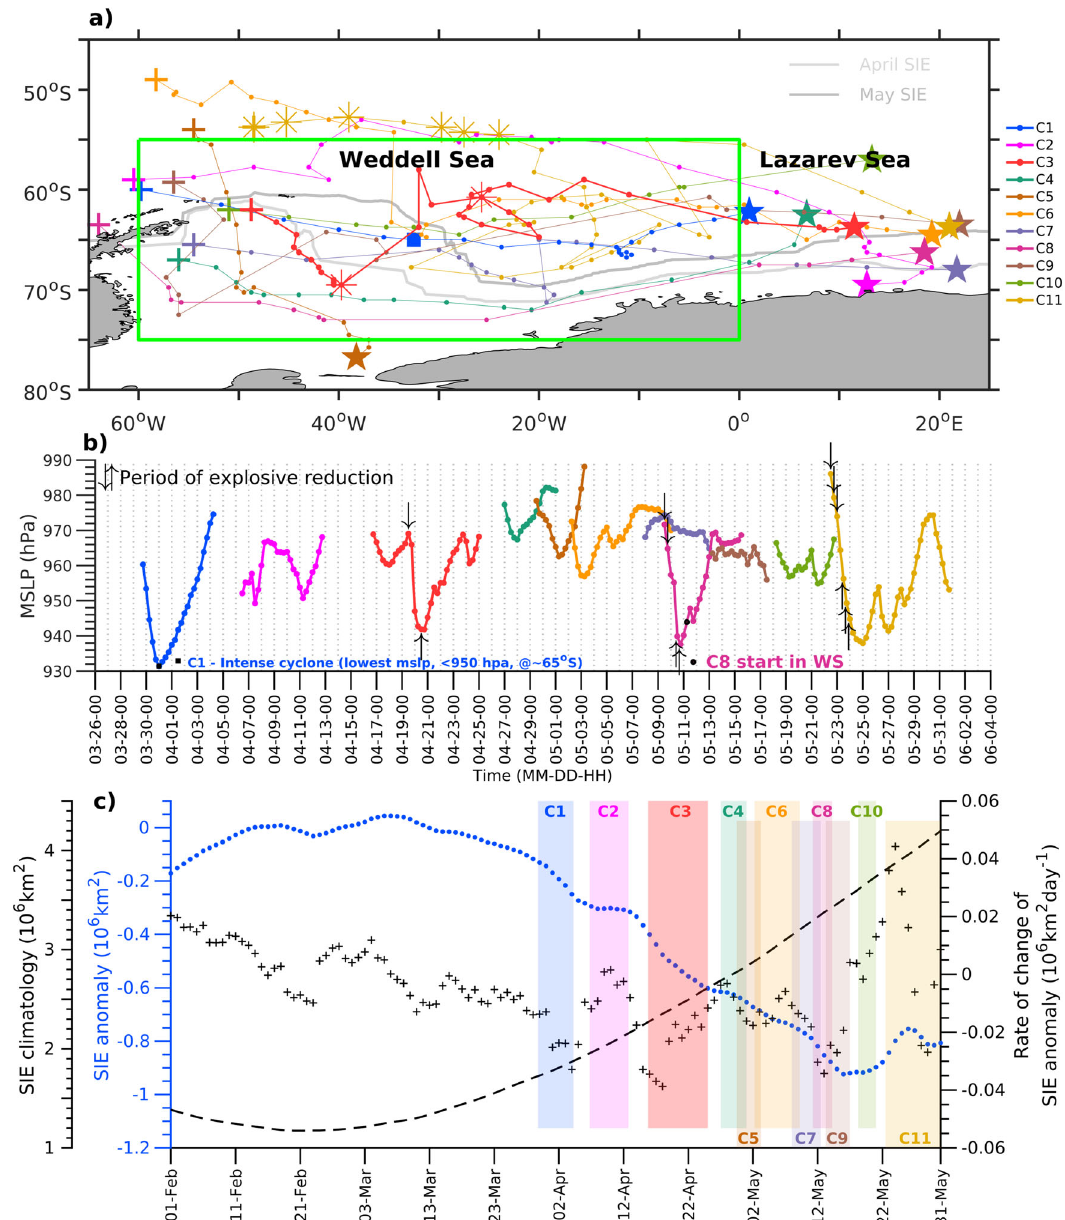
Fig. 2 Polar cyclones and sea ice extent (SIE) changes in the Weddell Sea. a Polar cyclone tracks during April – May 2019 are marked by lines with the dots indicating positions at 6 hourly intervals. Of the eleven cyclones (C1 – C11), three systems were explosive in nature (C3, C8, C11) that formed south of 60°S in the Weddell Sea during 16 – 25 April 2019 (C3), 11 – 15 May (C8), and 22 – 31 May 2019 (C11). Blue square represents the location of an unusual intense cyclonic system (C1) with a record low pressure. Occurrences of explosive events are marked in asterisks. For most of the systems, the cyclolysis (stars) occurred in the Lazarev Sea. The monthly sea ice edge relative to the cyclone tracks are shown for April (light gray) and May (dark gray) 2019. b Life cycle of polar cyclones including intense (square) and explosive (arrows) developments (Methods section ‘ Atmospheric reanalysis ’ ). c Daily SIE anomalies (blue dots) from 01 February to 31 May 2019 relative to the climatology of 1979 – 2008 (black dashed line), spatially-averaged over the Weddell Sea from 60°W to 20°E and 55°S to Antarctic coast (Methods section ‘ Sea ice observations ’ ). Vertical shaded bars represent the occurrence period of polar cyclones corresponding to SIE anomalies. The plus marks indicate the rate of change of SIE anomaly per day and has the largest negative changes during an explosive cyclones-C3, followed by two explosive cyclone-C1, C8 and cyclone C1 had an immediate impact on sea ice through extreme (SST) anomaly of up to ~ + 2 °C and mixed layer warming is evident changes in ocean ‒ atmospheric conditions, an anomalous warming between the low-pressure centre and bands of high wind stress of ocean mixed layer with record high values (>3 °C) persisting from associated with cyclone C1, that prevented thermodynamic growth the previous summer (January ‒ February 2019) continued well into of sea ice (Figs. 3g ‒ h, 4b). The regions of record low MSLP were the subsequent autumn (March ‒ May 2019) and played a role in correspondingly collocated with record high wind speed, IWVF, preconditioning for the negative sea ice anomalies (Fig. 4b, NHF, SAT, SHW, SST and MLT, indicating the major impact of Supplementary Fig. 5). The ocean preconditioning followed by cyclone C1 on the rapid sea ice decline (Fig. 3). Even though